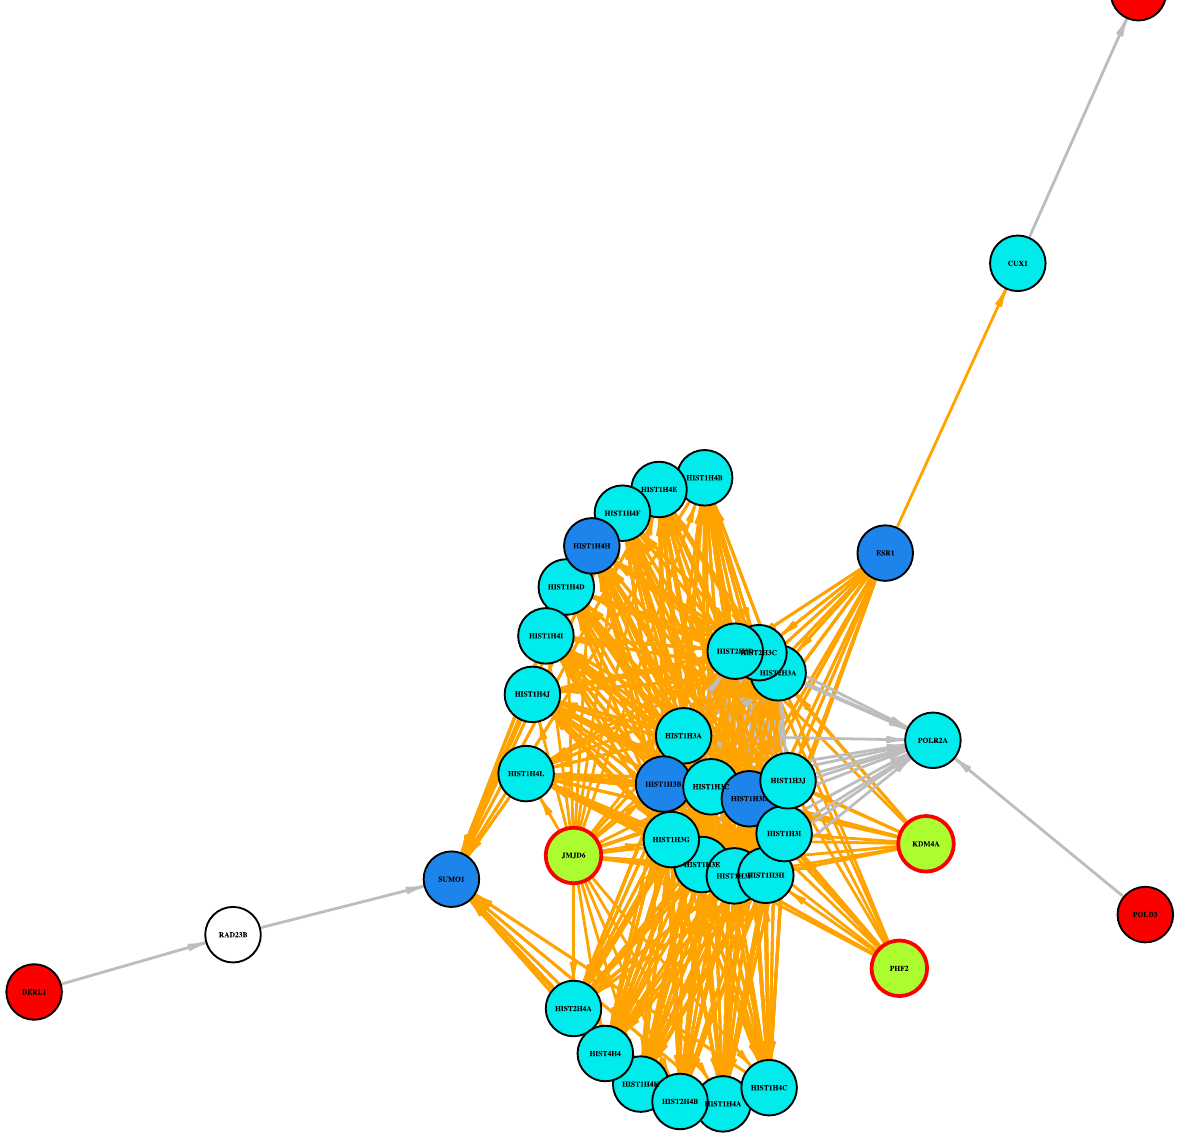
Fig 6. DERL1, MAN2A1 and POLD3: HDMs demethylate histones. Simplified diagram of the pathway ‘HDMs demethylate histones’ fusing the results of the enrichment analysis for regulators DERL1, MAN2A1 and POLD3. Key to nodes and edges as in Fig 5 with the addition of: Nodes: Red = regulator, White = target, not